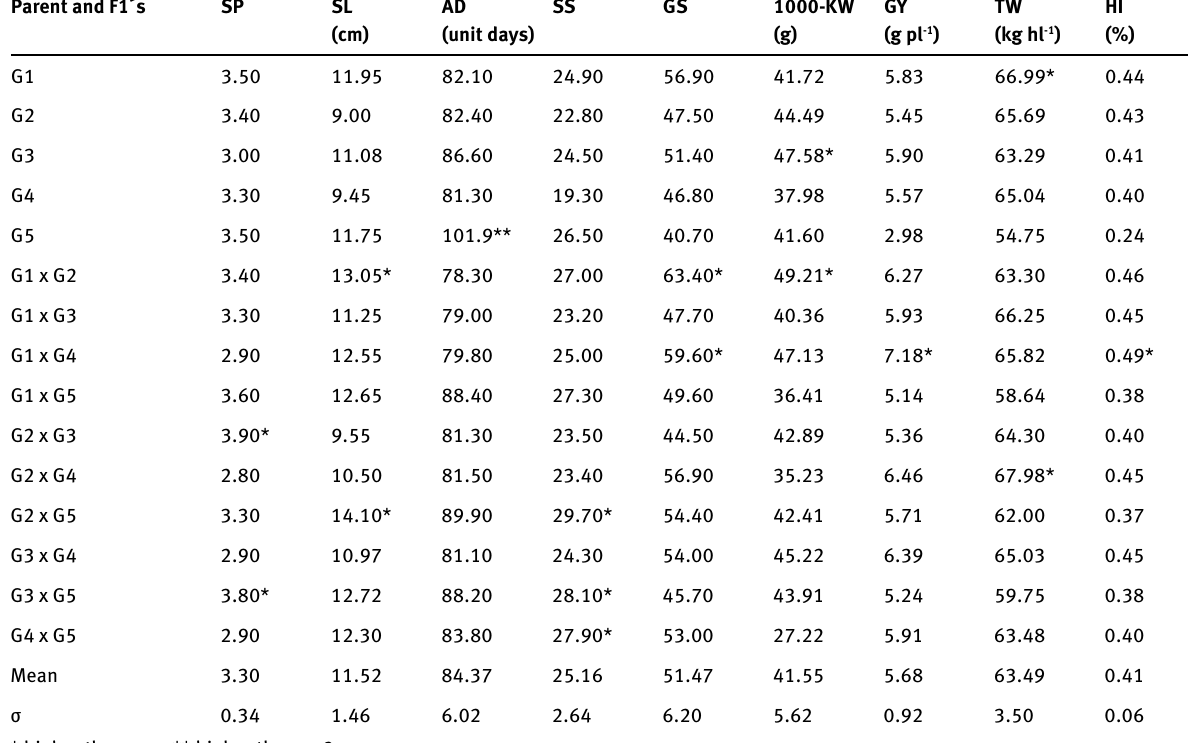
Table 2: Means of nine agronomic traits of five parents and their 10 crosses evaluated in Santa Rosa, La Pampa, during 2016 Parent and F1´s SP